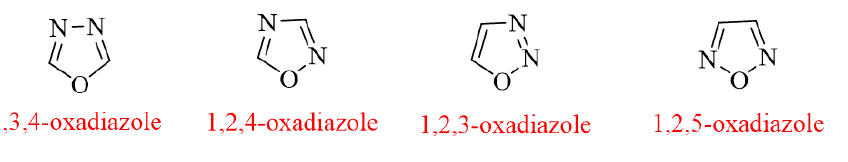
Figure 2. Leading types of cancers worldwide.